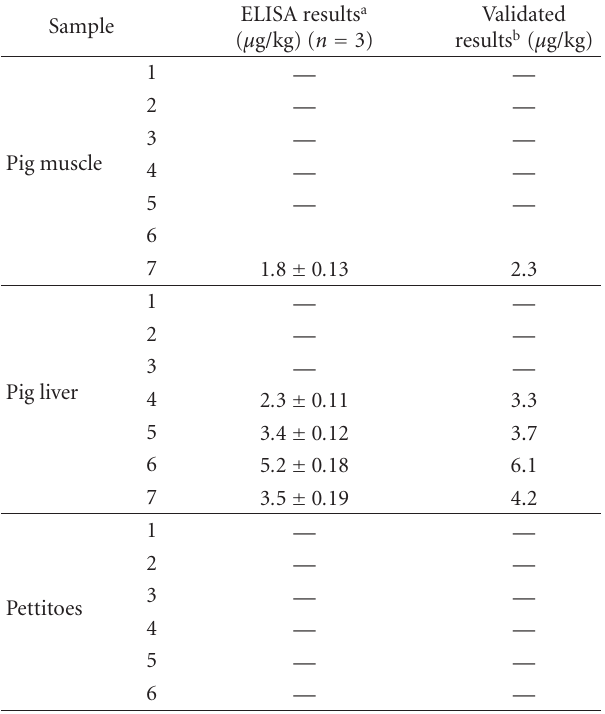
Table 4: Analysis results of real food samples obtained by ELISA and comparison with validated